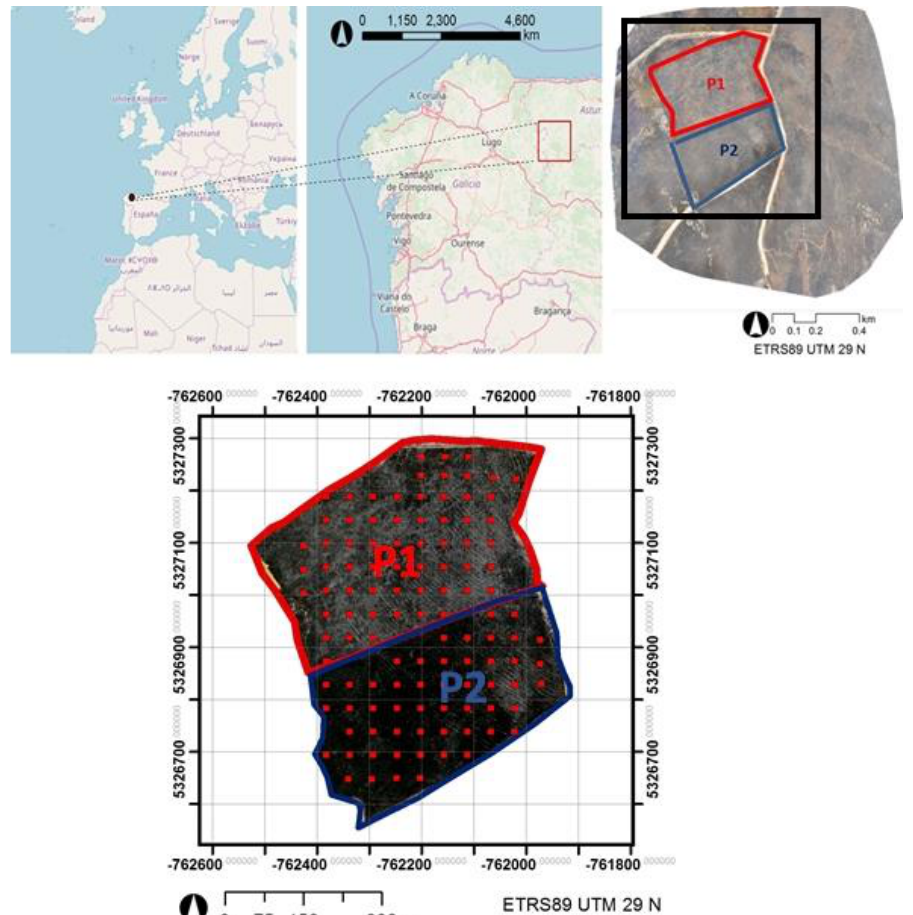
Figure 1. Upper: Location of the study area (left and centre) and field plots for the prescribed burns (right). Lower: Detail of field plots.